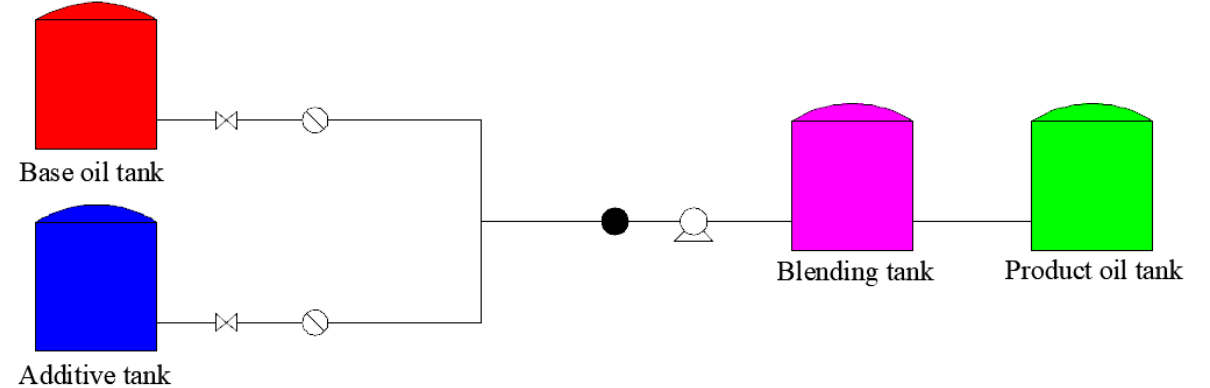
Figure 1. Production process of lubricating oil tank blending.